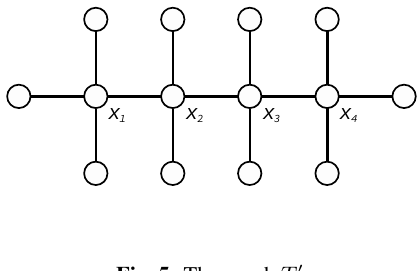
Fig. 5: The graph T (cid:48)